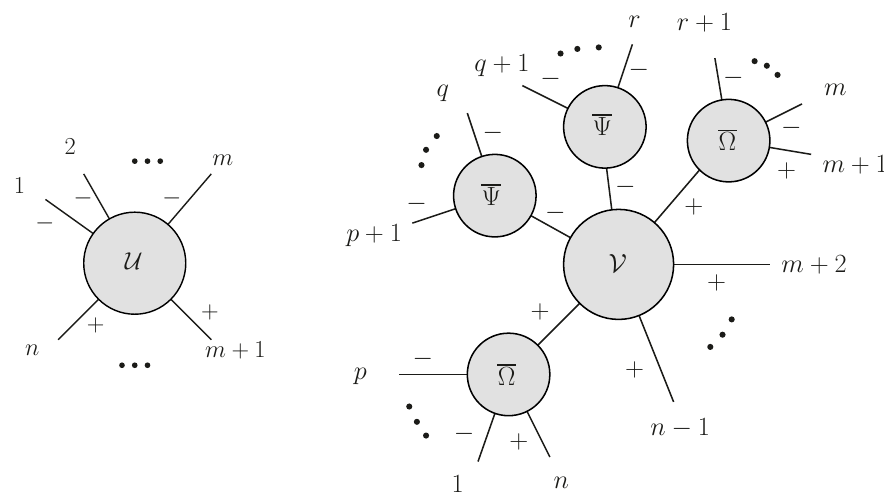
Figure 2 . Left: color ordered vertex in the Z -field theory with m minus helicity legs. Right: a general contribution to the Z -theory vertex. The central blob is the MHV